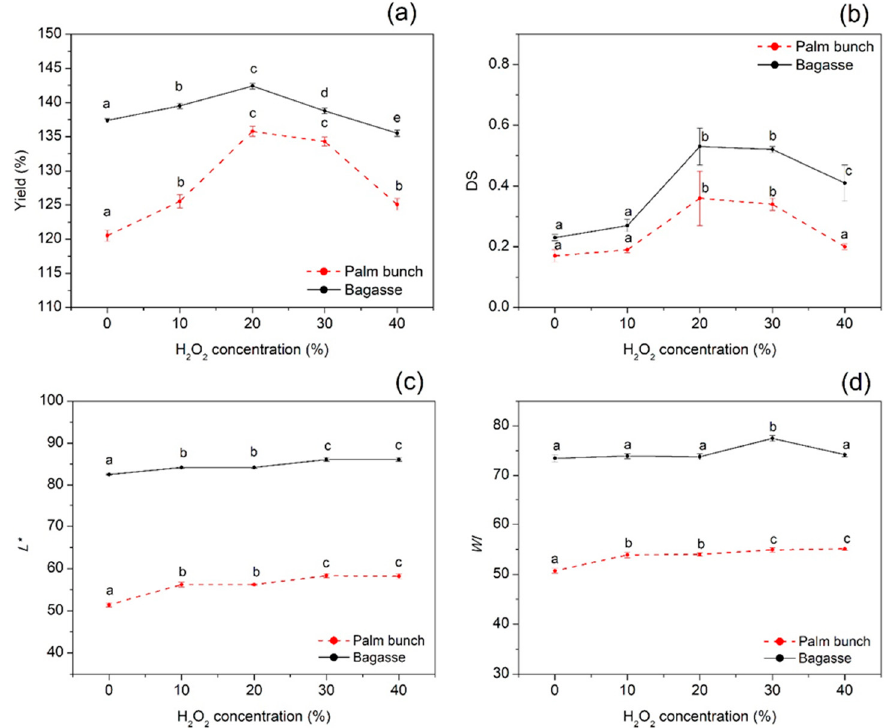
Figure 2. ( a ) Yield, ( b ) DS, ( c ) L* , and ( d ) WI of CMC from palm bunch and bagasse. Abbreviations: DS, degree of substitution; CMC, carboxymethyl cellulose.